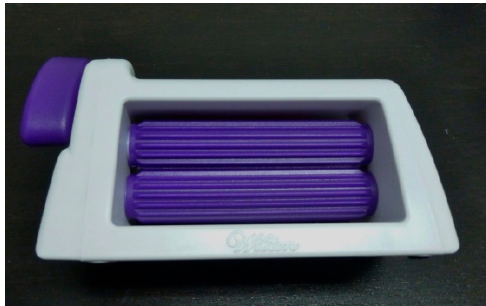
Figure A7. Cake icing roller.